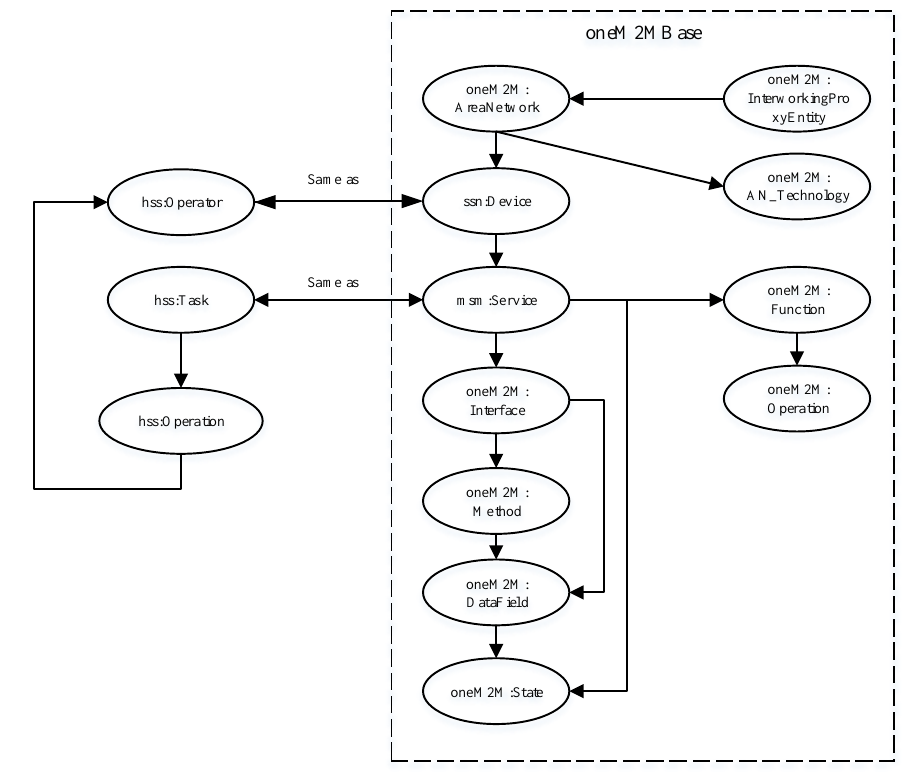
Figure 4. Mapping between hierarchical semantic service (HSS) ontology and oneM2Mbase ontology for generic